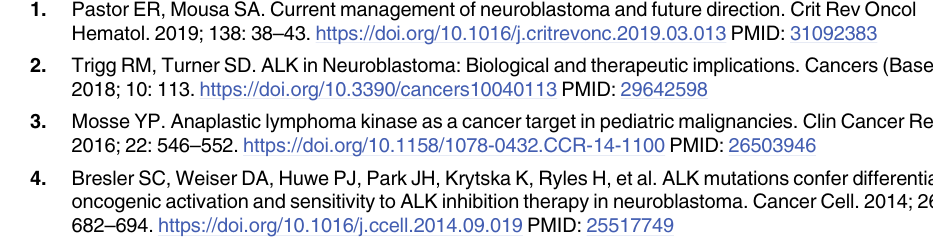
S7 Fig. Body weight and organ histology of mice after administration of CCC-003 in human ALK -mutated neuroblastoma xenograft models. SH-SY5Y cells were subcutaneously injected into the flanks of female immune-deficient BALB/c nu/nu mice. Administration of CCC-003 began when the average tumor size reached 500 mm 3 . (A) Body weight of mice was measured twice a week. Red arrows, timepoint of CCC-003 administration. Data are repre- sented as the mean ± SD. DMSO was used as a control. (B) After reaching the end point, tis- sues of the lung, liver, and kidney were collected and used for HE staining. Scale bars, 50 μ